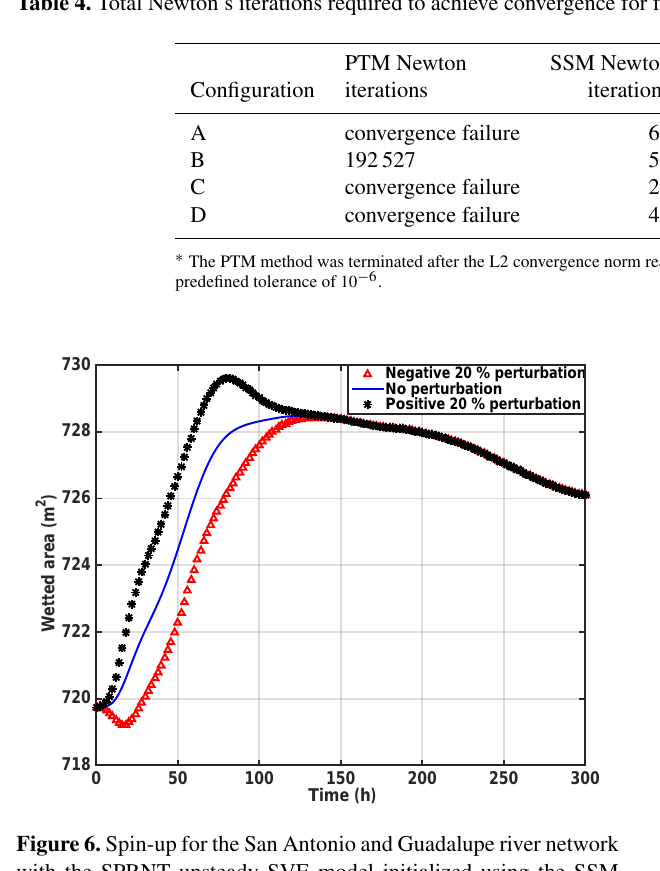
Table 4. Total Newton’s iterations required to achieve convergence for four configurations of the San Antonio and Guadalupe river network.